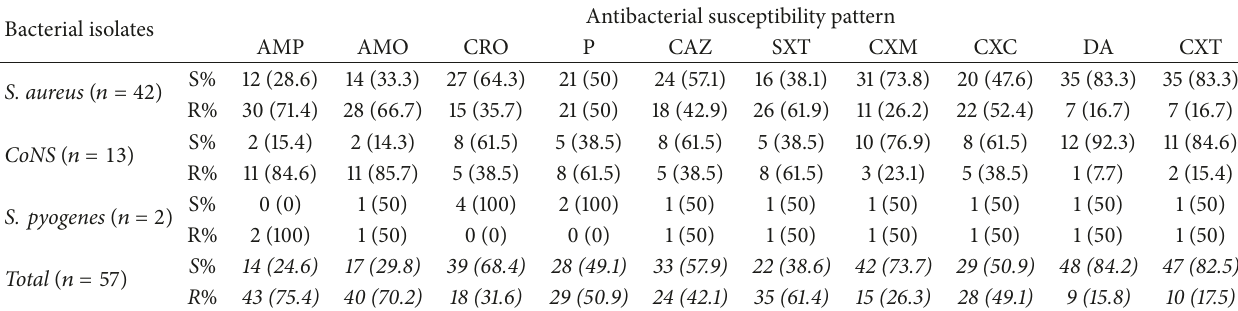
Table 2: Antibacterial susceptibility pattern for Gram-positive SSI causing pathogens from women attending postnatal service at University of Gondar Teaching Hospital from 1 January 2016 to 30 May 2016. Bacterial